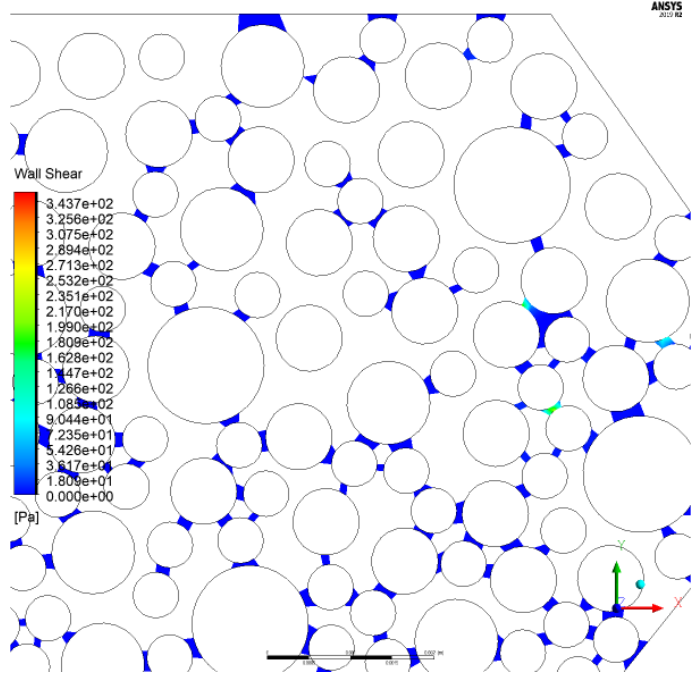
Figure 14. Contour of wall shear stress for case 3 at 300 s.